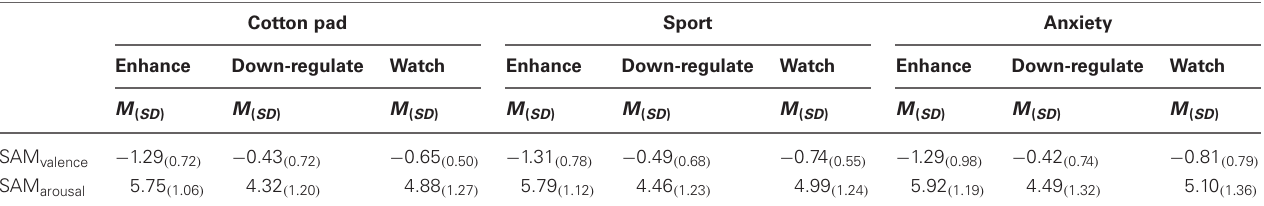
Table 5 | Emotion regulation effects on subjective ratings for anxious faces in the context of chemosensory anxiety, sport-control or cotton pad stimuli in Experiment II (EEG).